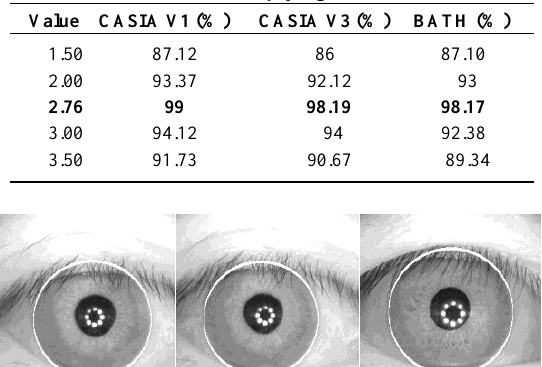
Table 2. Accuracy rate of iris outer boundary localization for different values multiplying on three databases.